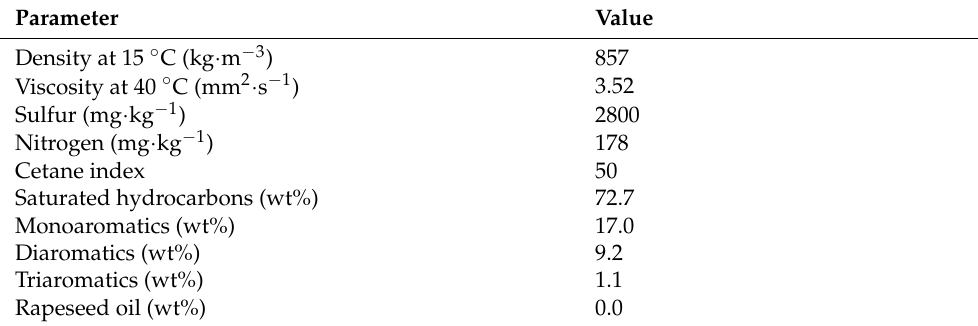
Table 9. The properties of the F0